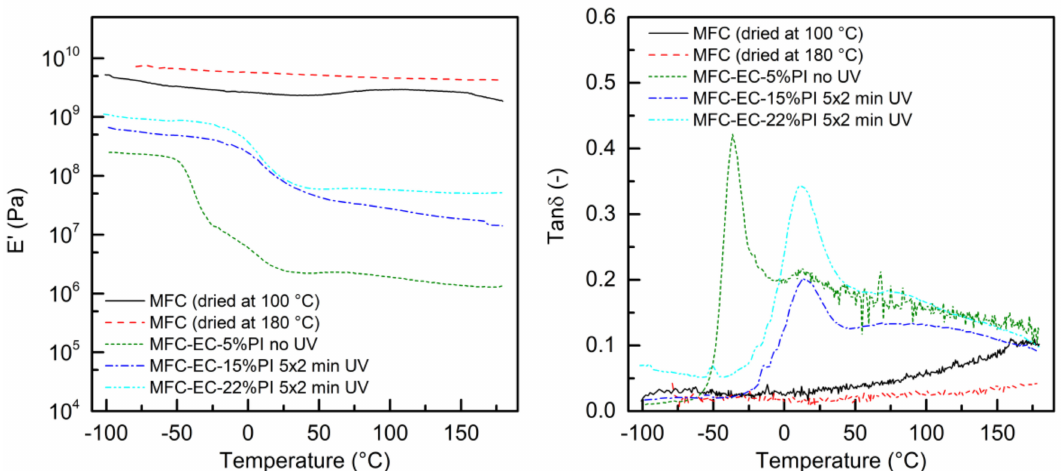
Figure 13. Storage modulus E’ and loss tangent (tan δ ) as a function of temperature for uncured and cured composites, and of the MFC mat dried at 100 ◦ C and 180 ◦